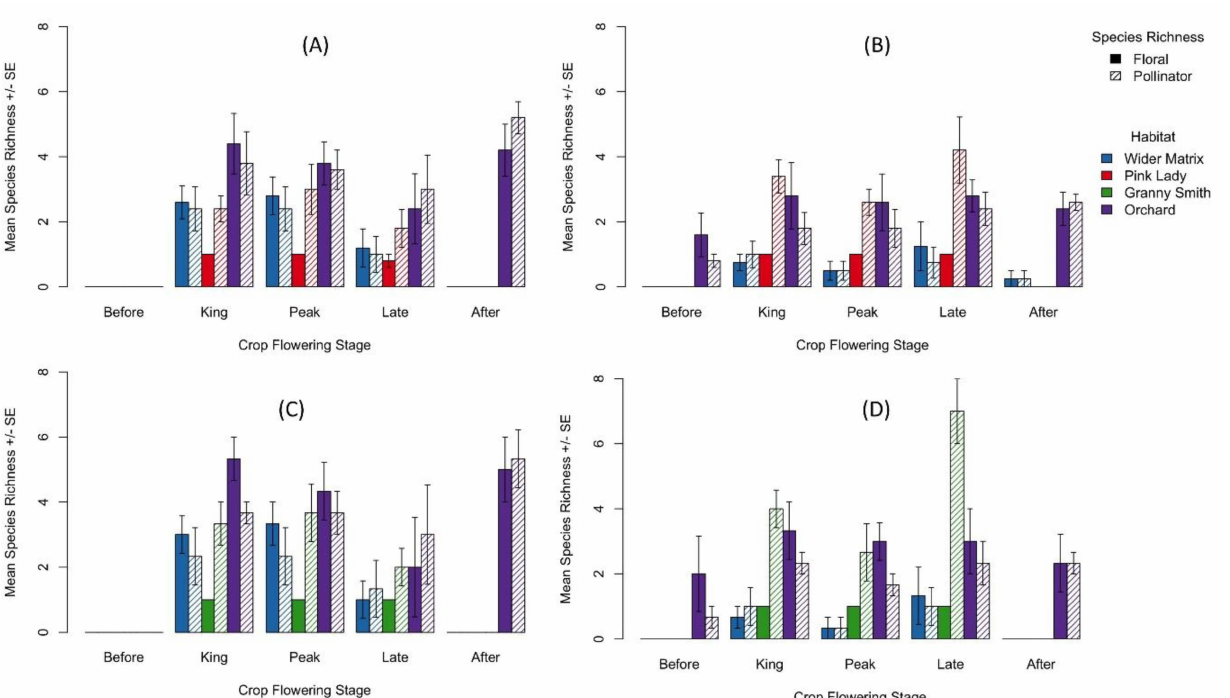
Figure 1. Mean species richness ( ± standard error) of pollinators (solid fill) and flowering plants (hatching) within the wider matrix (blue) and within orchard (purple) and on Pink Lady apple flowers (red) in 2017 ( A ) and 2018 ( B ) and Granny Smith apple flowers (green) in 2017 ( C ) and 2018 ( D ) (before, king, peak, late and after apple bloom) in Bilpin.